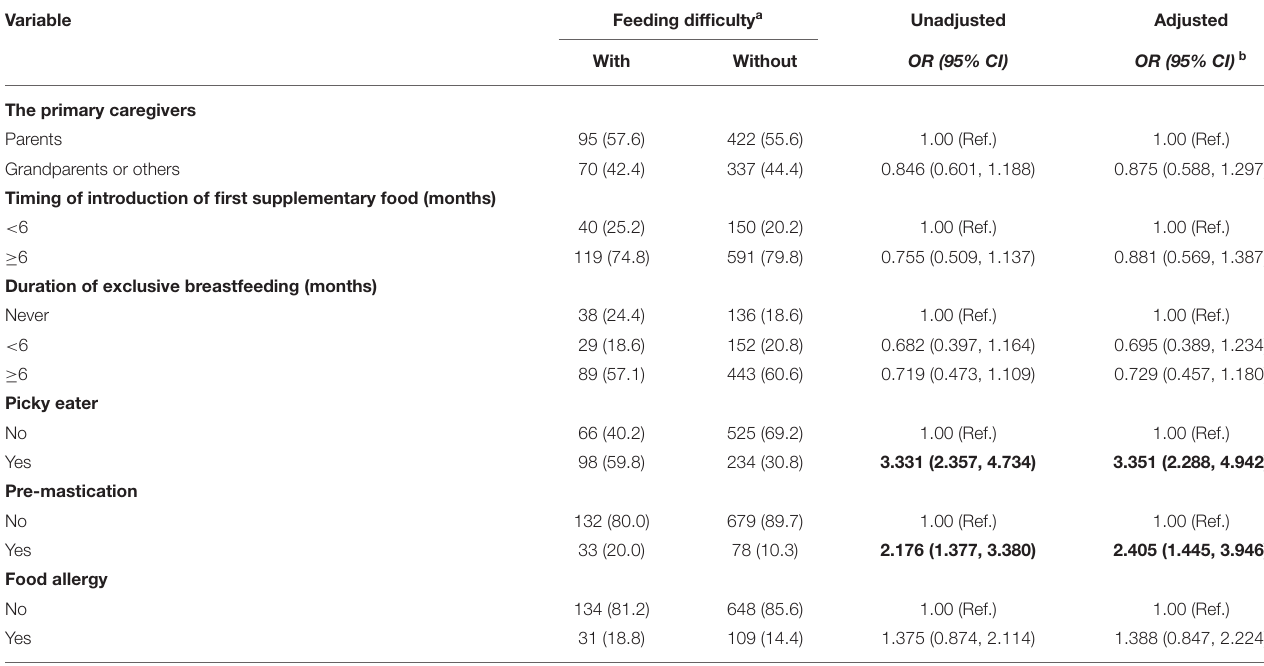
TABLE 2 | Association between feeding-related characteristics and feeding difficulty. Variable Feeding difficulty a Unadjusted Adjusted With Without OR (95% CI) OR (95% CI)